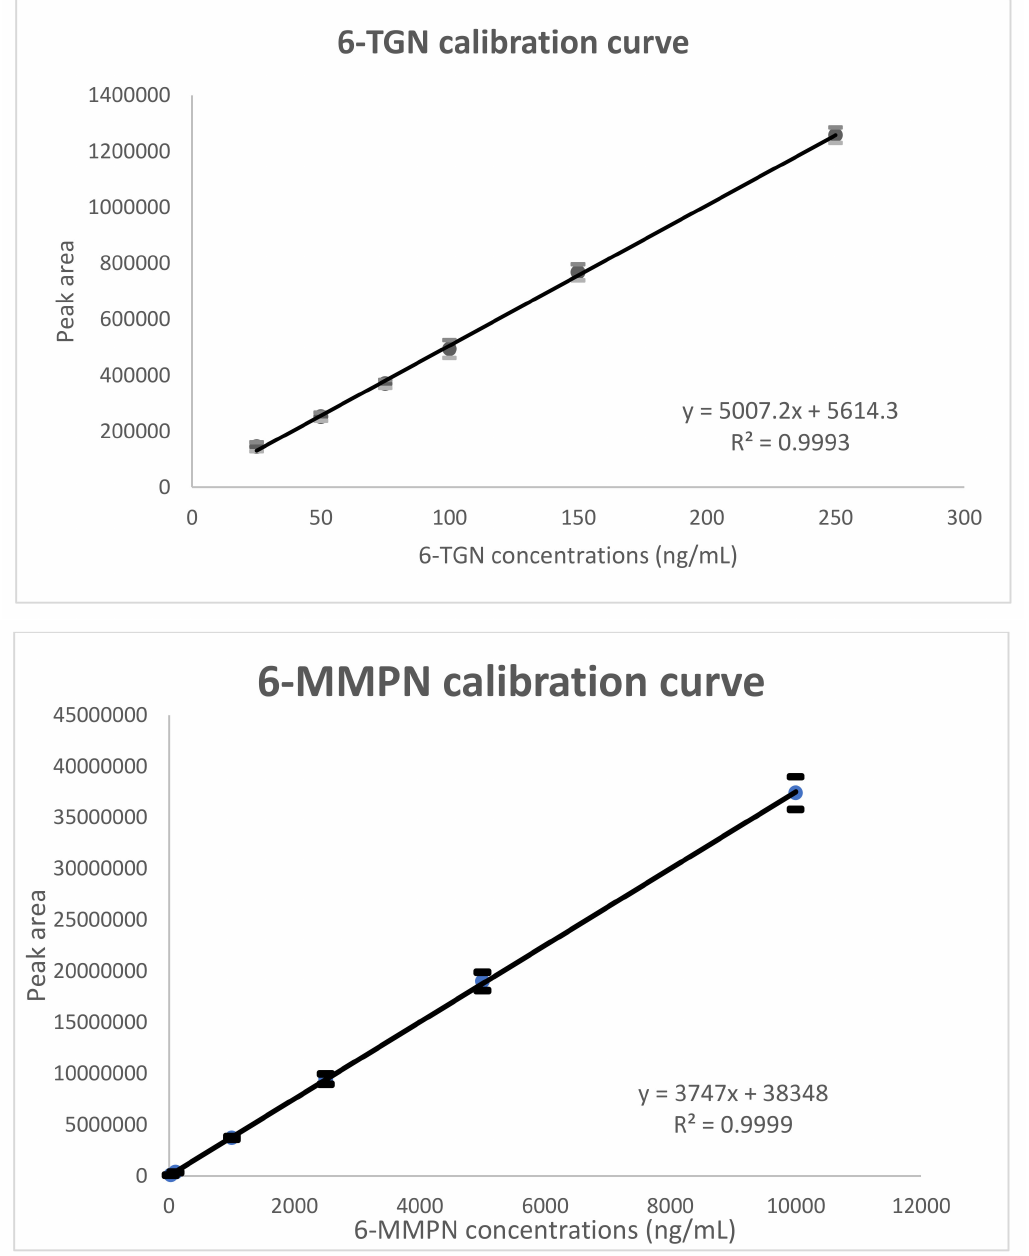
Figure 2. Mean calibration curves for 6-TGN and 6-MMPN. Mean (and standard deviation) concentrations ( n = 7) are presented at each point. Details of the seven calibration curves for both 6-TGN and 6-MMPN are also presented in Tables S1 and